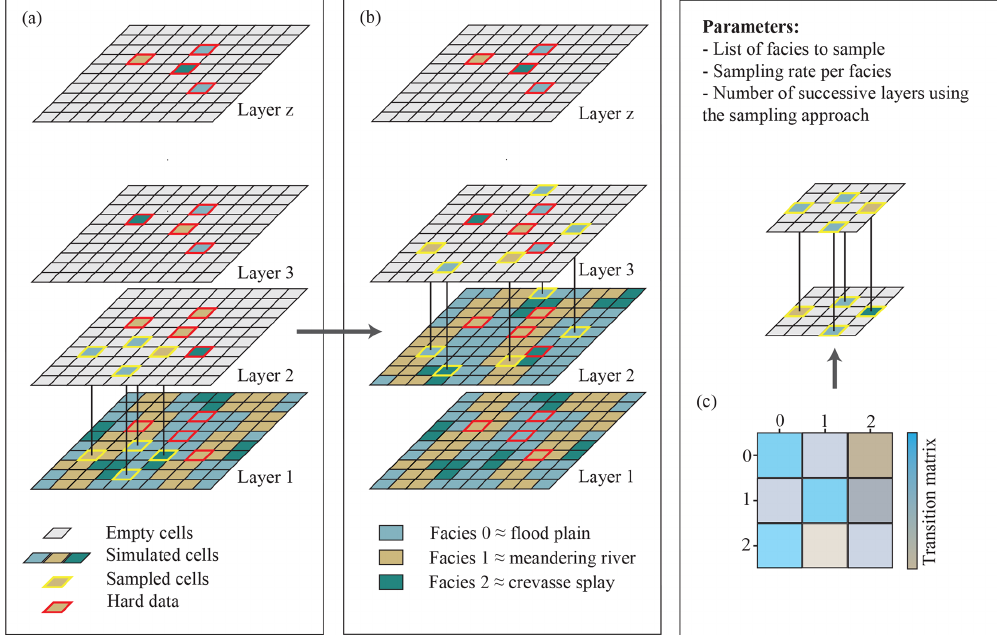
Figure 6. (a) The first simulation takes place with only the hard data set as conditioning data. Then a set of cells is sampled (in yellow) and used as new conditioning data for the next simulation. (b) The process is repeated until the defined number of successive layers is reached. Once reached, a simulation takes place without a sampling set. (c) The value of the sampled cell is drawn based on the vertical transition matrix, calculated from the borehole data